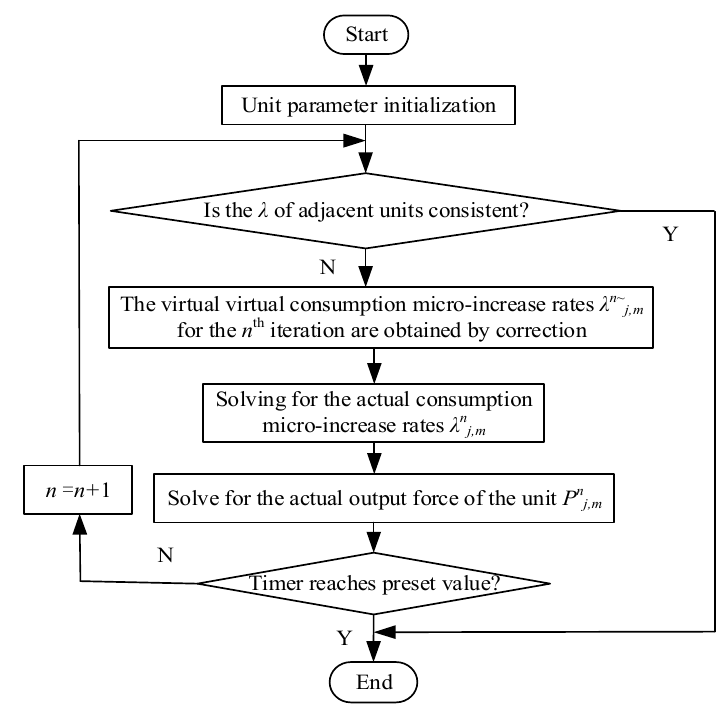
Figure 6. Power balance distribution process chart.